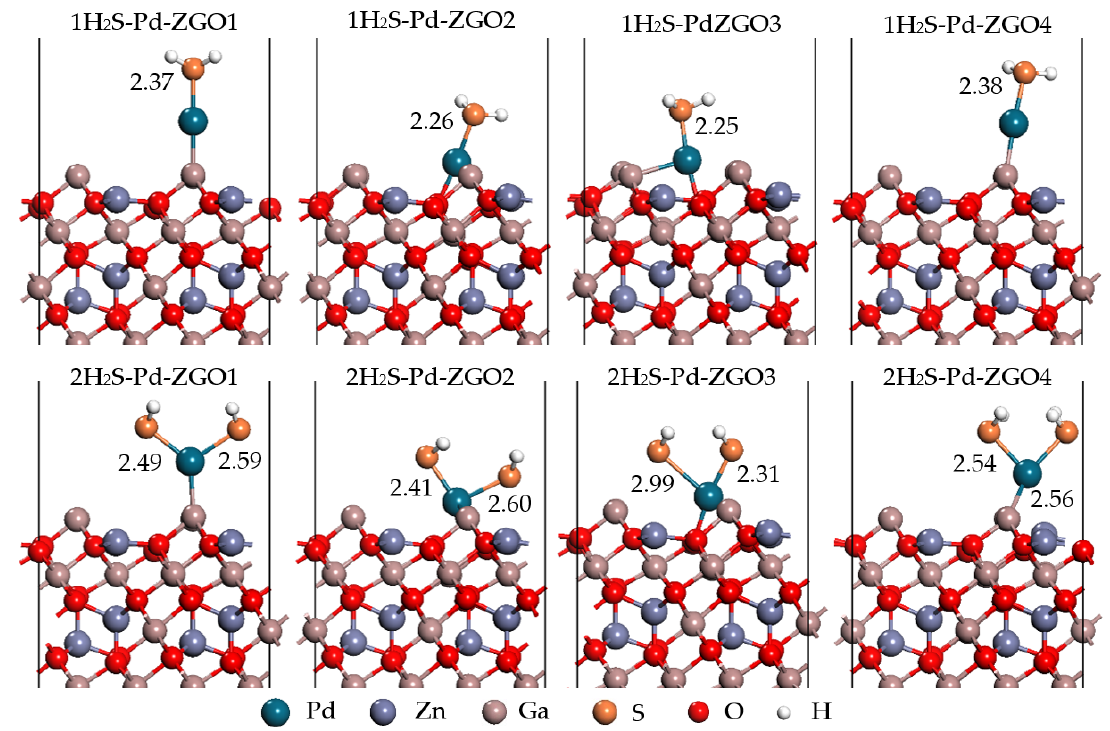
Figure 4. Side view of the n H 2 S molecules on Pd-ZnGaO i surface. The equilibrium bond lengths of n H 2 S-Pd-ZGO i are listed in Table 1.